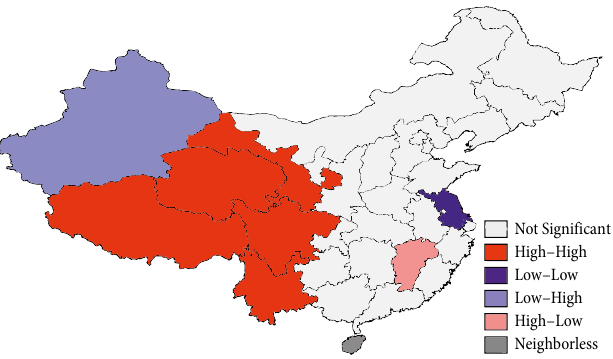
Fig. 5. The Local Moran’s Index of provincial education expenditure growth during 2006 and 2010